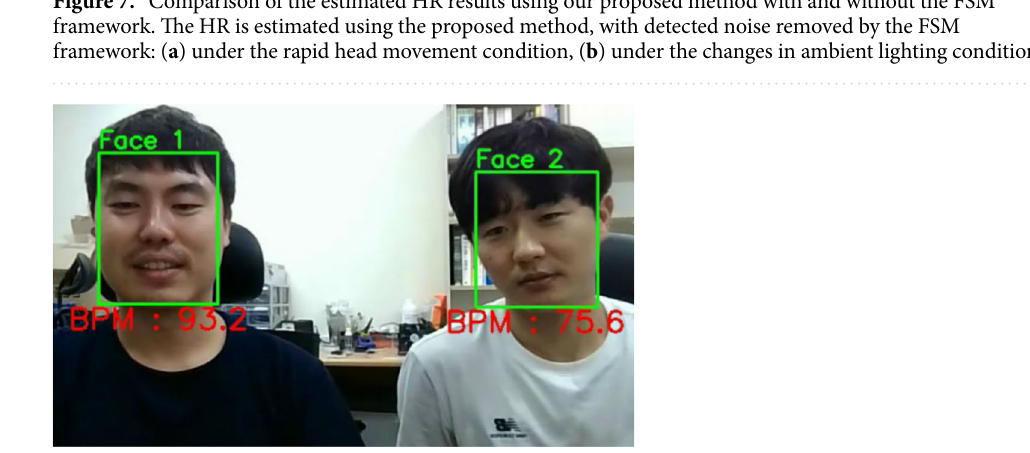
Figure 8. Simultaneous HR estimation of two subjects (additional dataset): An ID is automatically assigned to each face, starting from one, and the face frames from each subject are converted to HR values (both participants provided written informed consent for the publication of identifying images in an online open- access